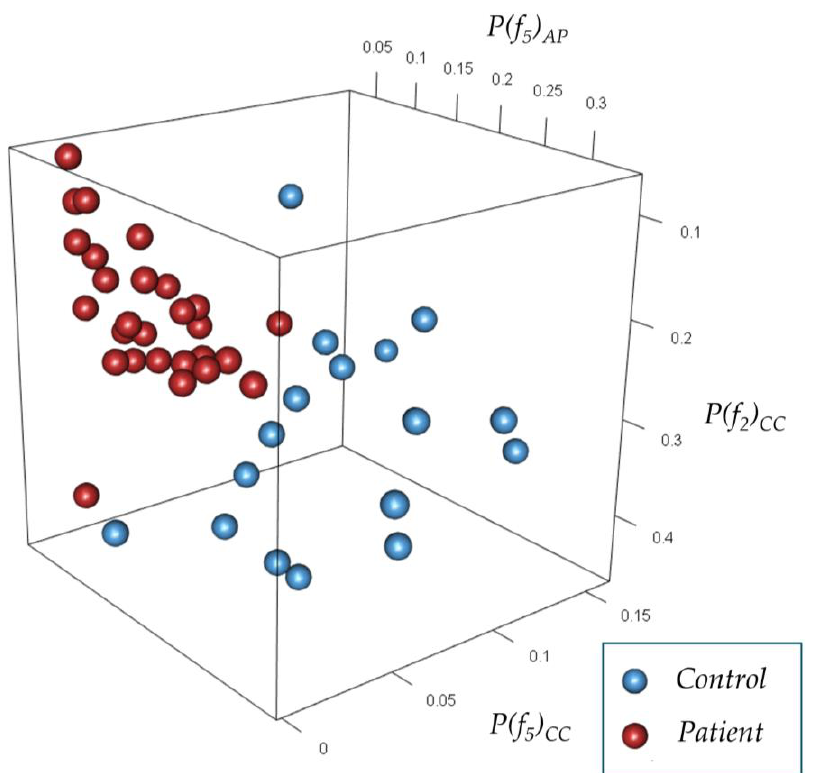
Figure 4. The cluster of the patients and controls based on the three most determining coefficients of the model: the power of the second and fifth frequency in the CC axis and the power of the fifth frequency in the AP axis.